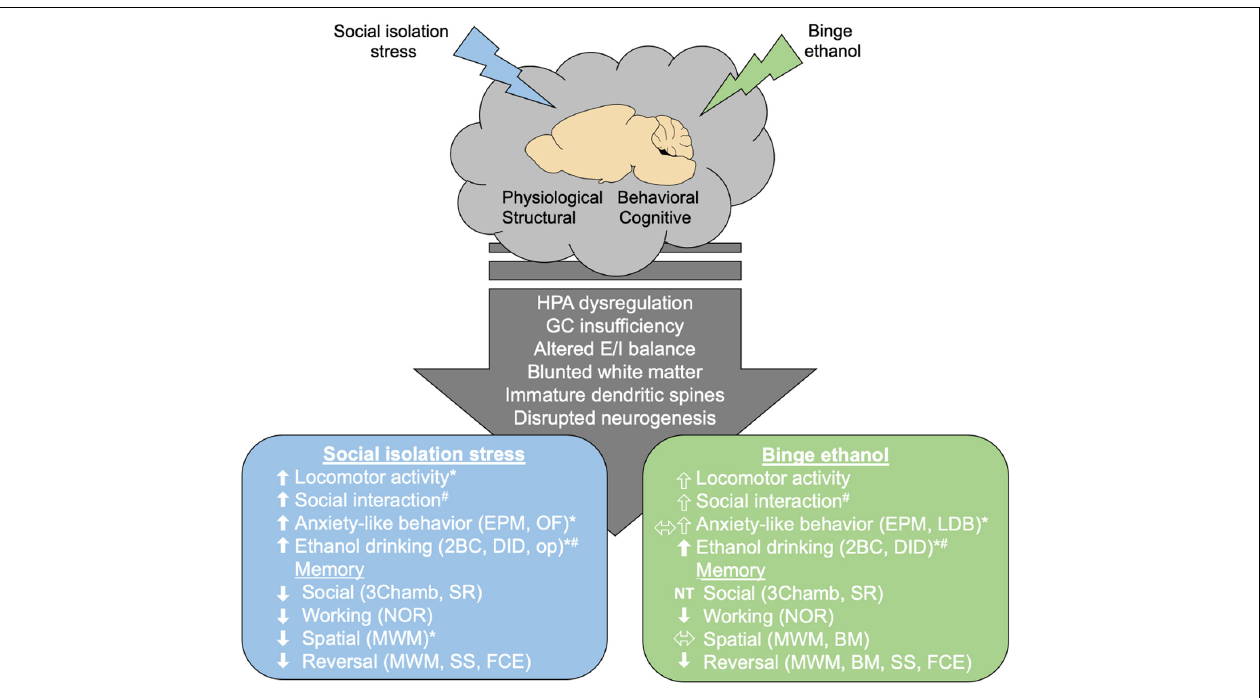
FIGURE 1 | Effects of social isolation stress or binge ethanol in adolescence. The adolescent period is characterized by physiological and structural changes that help mature brain connectivity leading to adult typical behavior and cognition. Postweaning social isolation or binge ethanol in adolescence ( ∼ PND 28–50) alters HPA function, brain connectivity, and generally retains adolescent phenotype (decreased white matter and improper dendritic spine pruning). As reviewed, social isolation stress or binge ethanol increased social interaction, anxiety-like behavior and ethanol drinking. Memory deficits were found following both paradigms. * Indicates conflicting findings in some studies. # Indicates sex differences were reported. Arrow outlines indicate that the effect depends if acute ethanol is used. HPA, hypothalamic pituitary adrenal axis; GC, glucocorticoid; E/I, excitatory/inhibitory; EPM, elevated plus maze; OF, open field; LDB, light dark box; 2BC, 2-bottle choice; DID, drinking in the dark; op, operant responding; 3chamb, 3-chamber social interaction task; SR, social recognition; NOR, novel object recognition; MWM, Morris water maze; BM, Barnes maze; SS, set shifting; FCE, fear conditioned extinction.